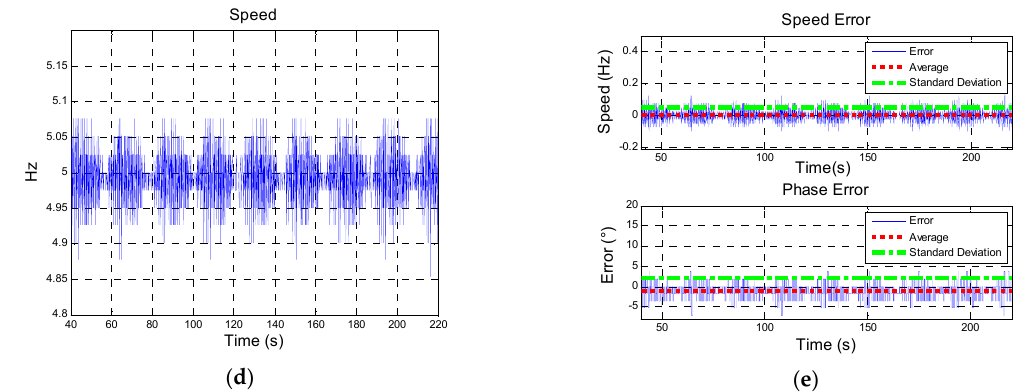
Figure 21. Results of group 1: ( a ) Description of digital amplitude of B Z ; ( b ) Comparison of pulses produced by hall sensor and controller and ( c ) is part of ( b ); ( d ) Description of speed figured out from controller; ( e ) Description of speed error and phase error.